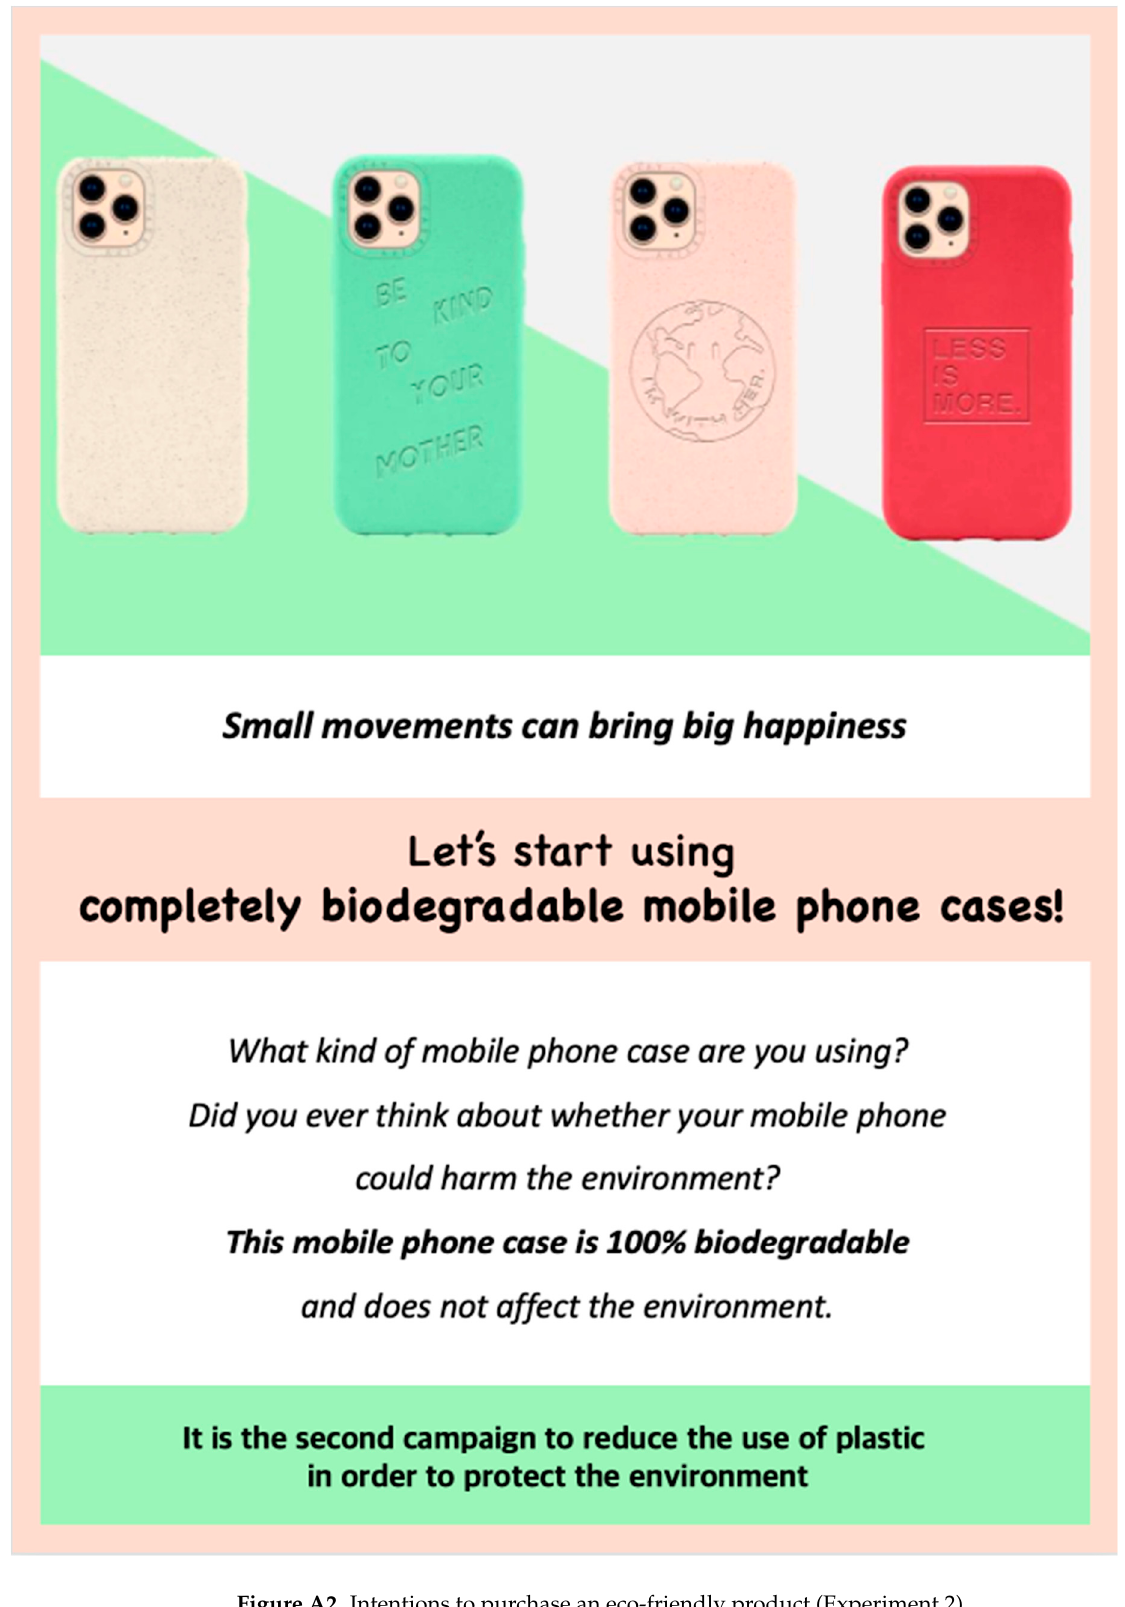
Figure A2. Intentions to purchase an eco-friendly product (Experiment 2).